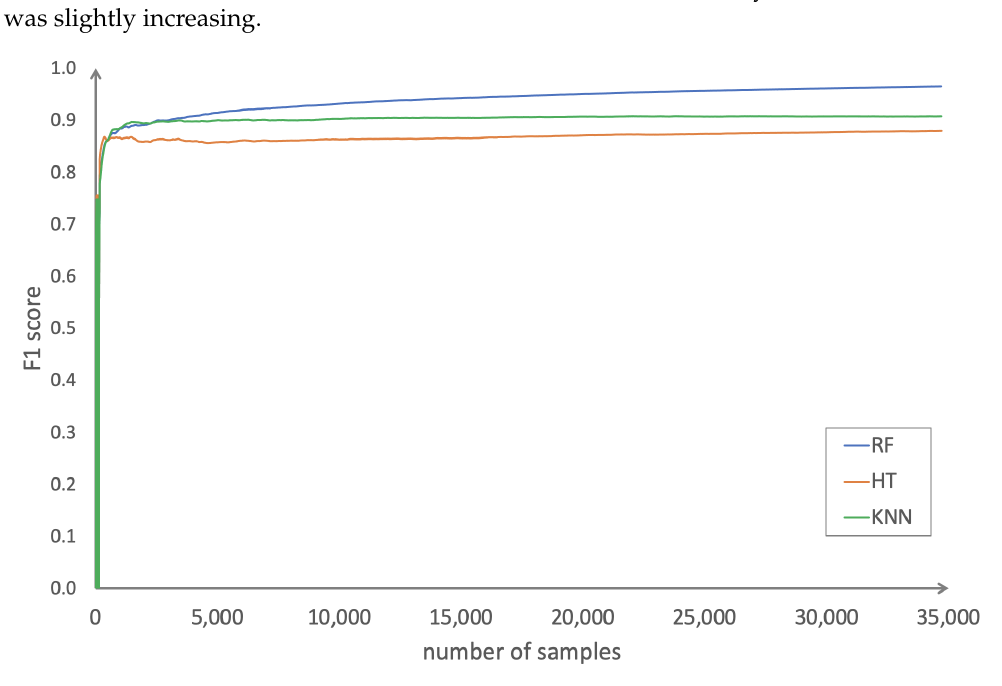
Figure 1. F1-score convergence for random forest (RF), Hoeffding (HT), and KNN.